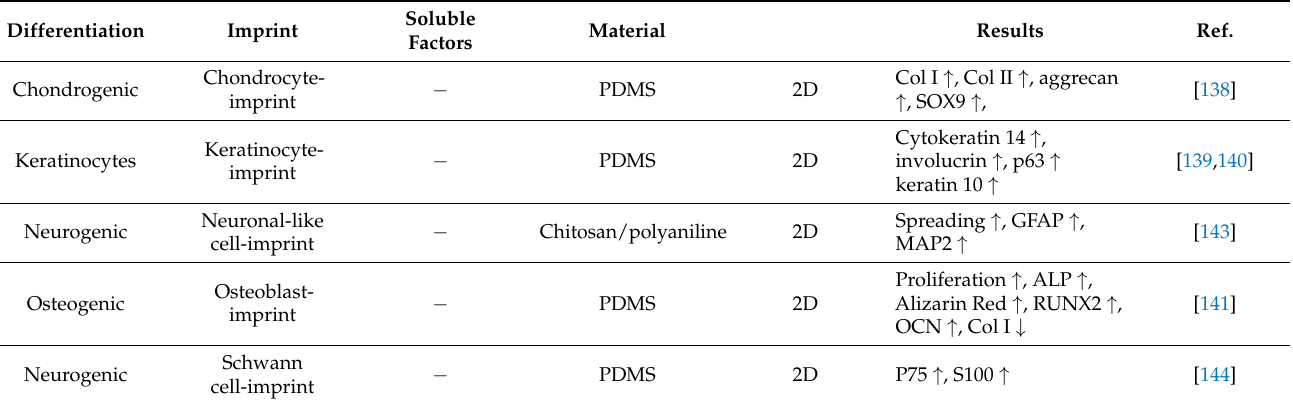
Table 4. Overview of the influence of cell-imprinted structures on ASCs. (PDMS: